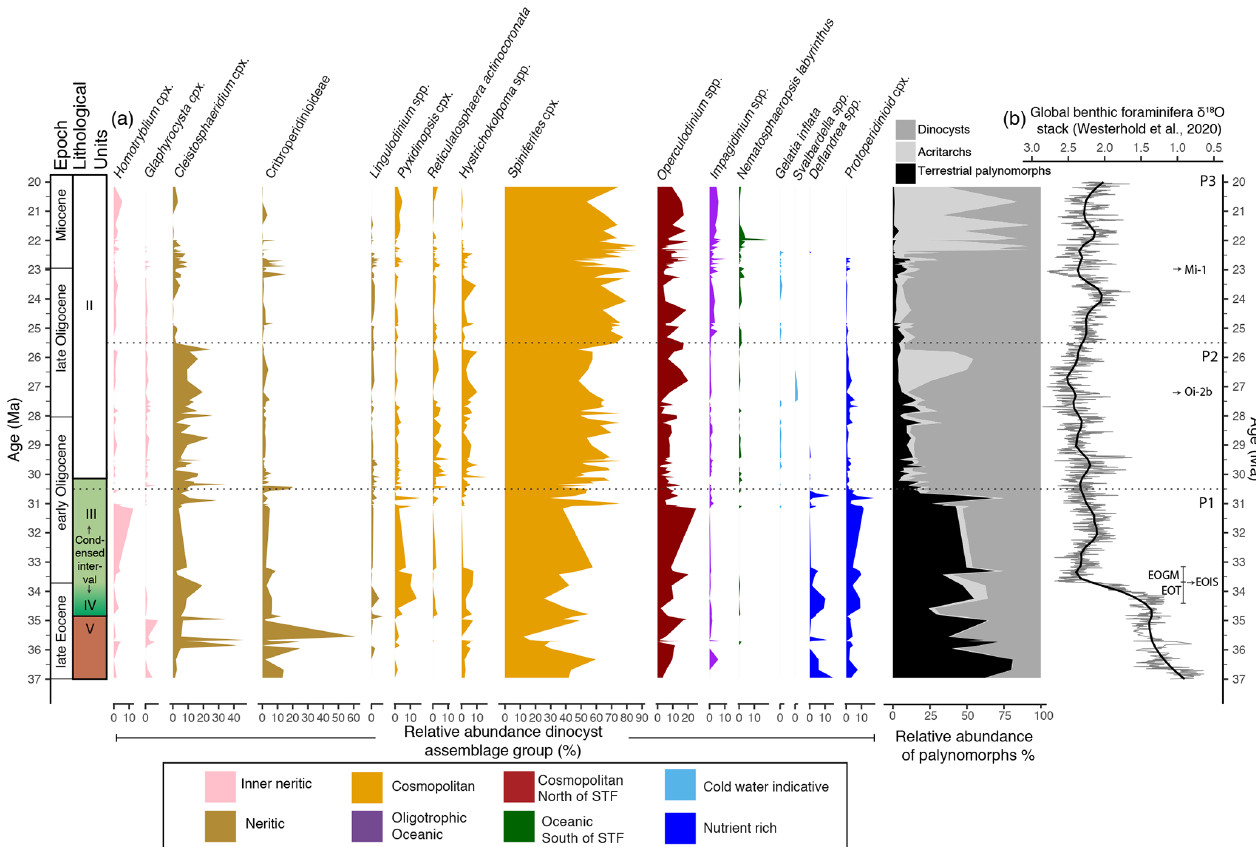
Figure 5. (a) Relative abundance (%) of selected dinocyst taxa and/or groups (Table 1), ordered from their known occurrence in inshore (left) to offshore (right) environments, with heterotrophic taxa (light and dark blue) to the right. Dinocyst taxa have been assigned to an ecological group (see legend), based on the context of this study, consistent with interpretations from Röhl et al. (2004) and Frieling and Sluijs. (2018). The relative abundance of terrestrial palynomorphs, acritarchs and dinocysts with respect to the total palynomorph counts is shown in greyscale. (b) Global benthic foraminiferal δ 18 O stack record by Westerhold et al. (2020). The thick black line represents the loess smoothing curve with a span of 0.1. Selected isotopic events are marked, following Hutchinson et al. (2021): EOT is the Eocene–Oligocene transition, EOGM is the earliest Oligocene glacial maximum, EOIS is the earliest Oligocene oxygen isotope step, Oi-2b is the Oligocene glaciation/isotopic event 2b and Mi-1 is the Miocene glaciation/isotopic event 1. The stippled black lines at 30.5 and 25.5Ma distinguish the three phases/time intervals (P1, P2 and P3) discussed in Sect.